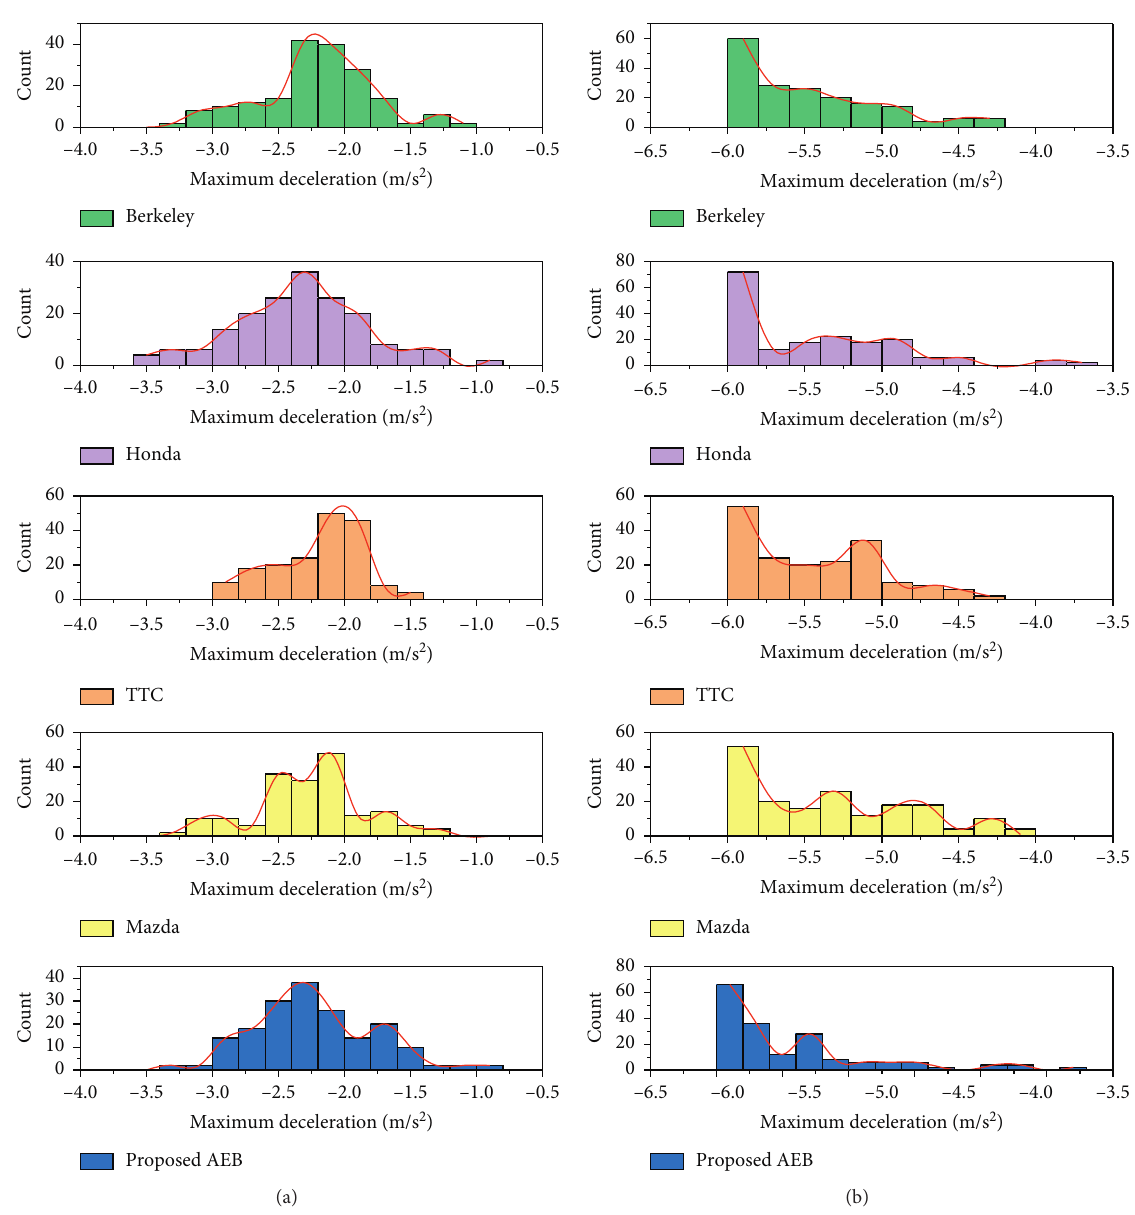
Figure 7: Braking deceleration distribution of drivers under different braking intentions: (a) normal braking intention; (b) emergency braking